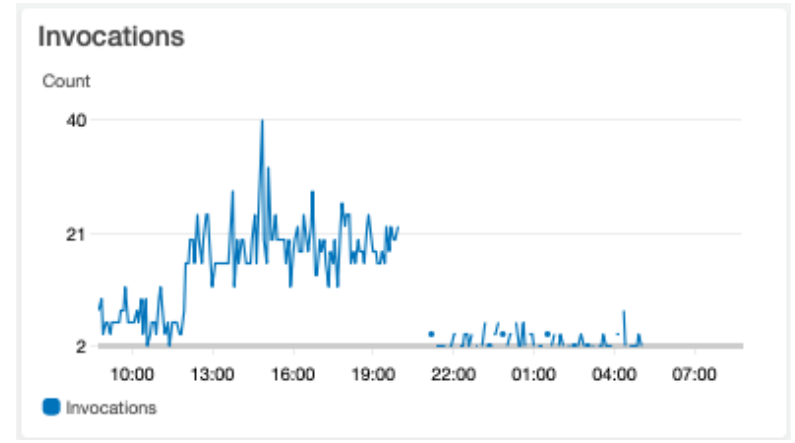
Figure 7. Intervals invocations.